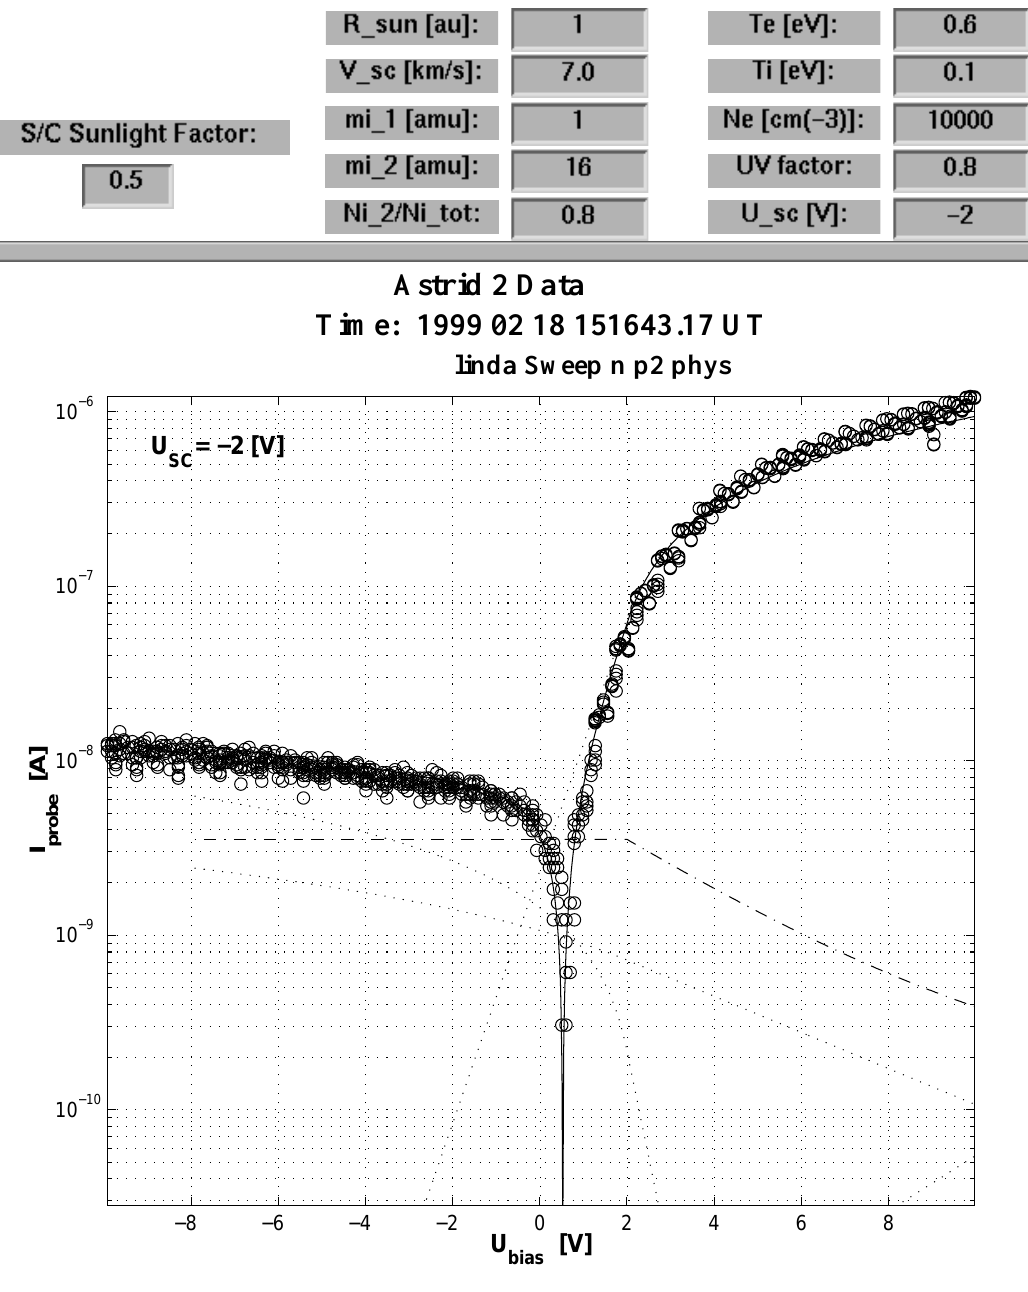
Fig. 3. An example of a probe bias voltage sweep performed by LINDA. As is typical for sweeps in Normal-Burst operations (Sect. 8), the bias voltage is swept in 256 steps from + 10 V to − 10 V and then back again, typically in 2 seconds. A fit to the theoretical (OML) expression by Mott-Smith and Langmuir (1926) yields the physical parameters stated on top of the